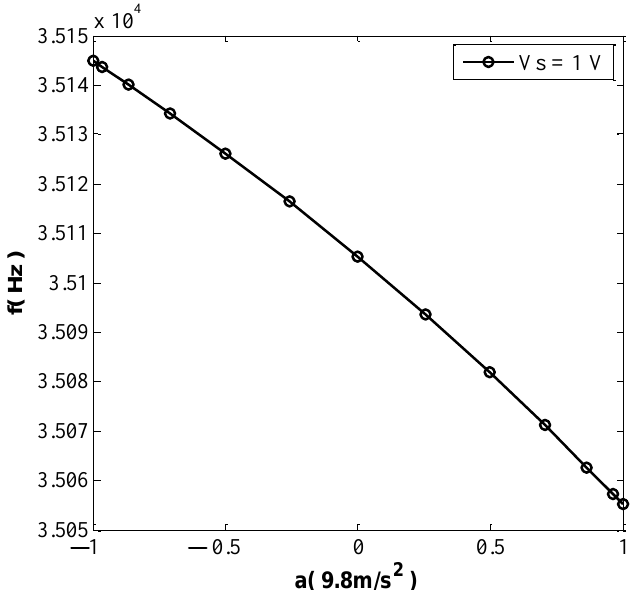
Figure 20. Output characteristic test (Vs = 1 V).